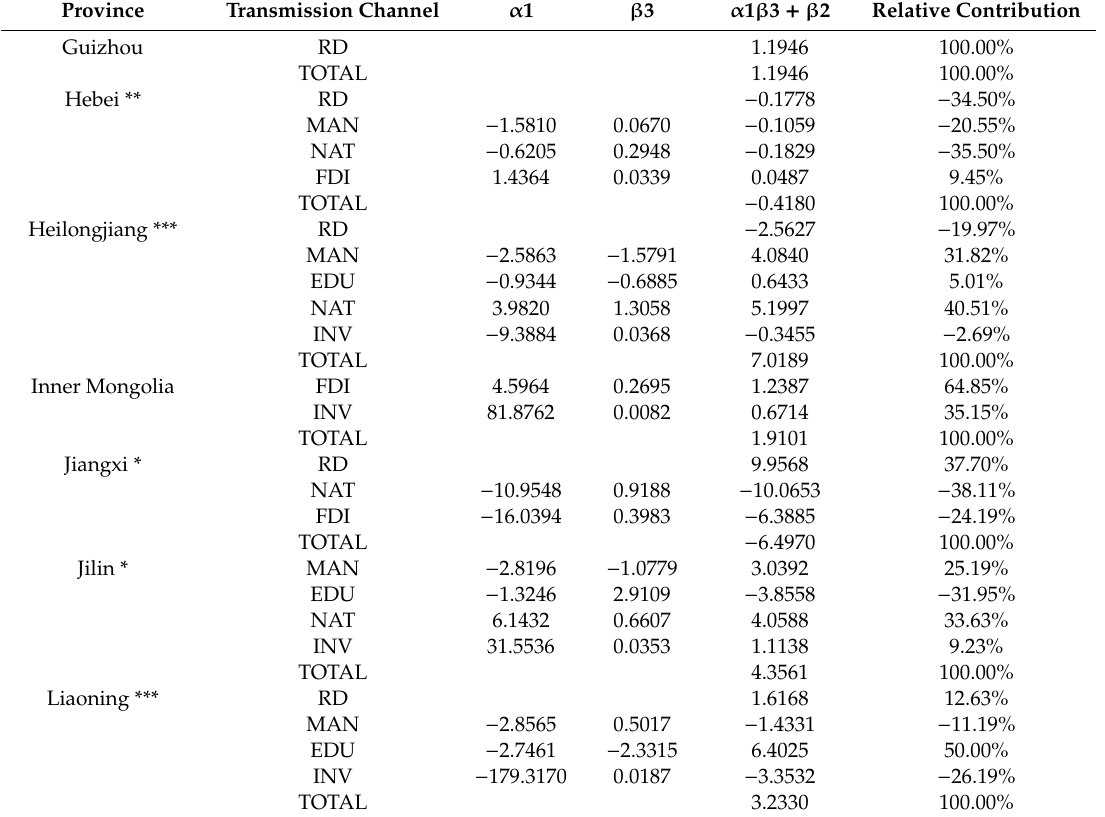
Table 7. The relative importance of transmission